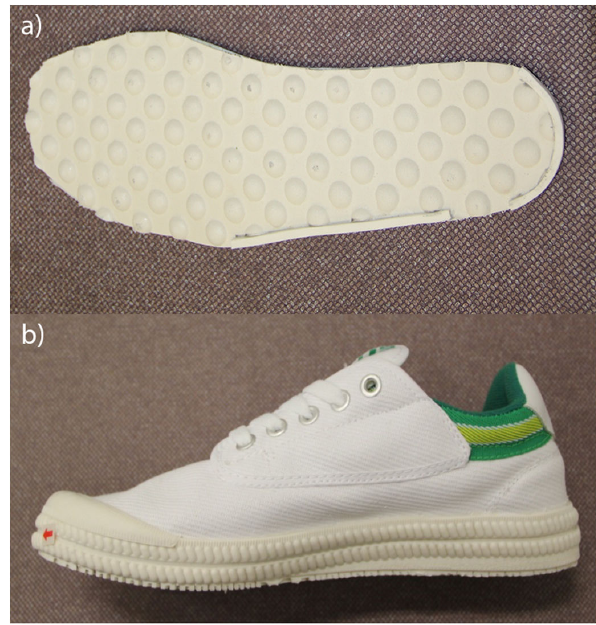
Figure 1. The characteristics of the textured insole (a) and the basic construct rubber-soled shankless shoe (b) used in this research.